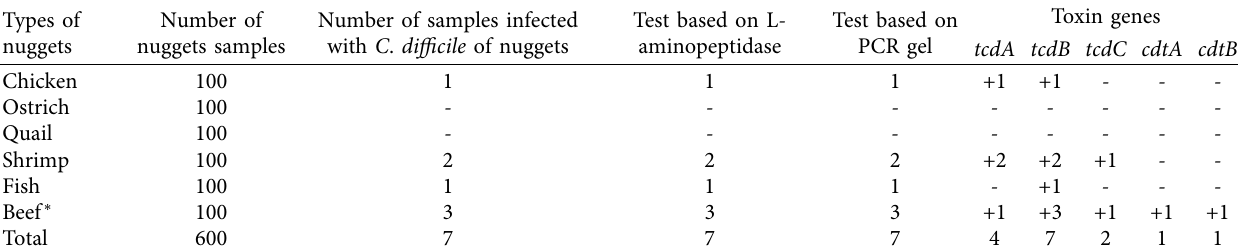
Table 1: Examining the infection and genetic diversities of C . difcile strains in nuggets.